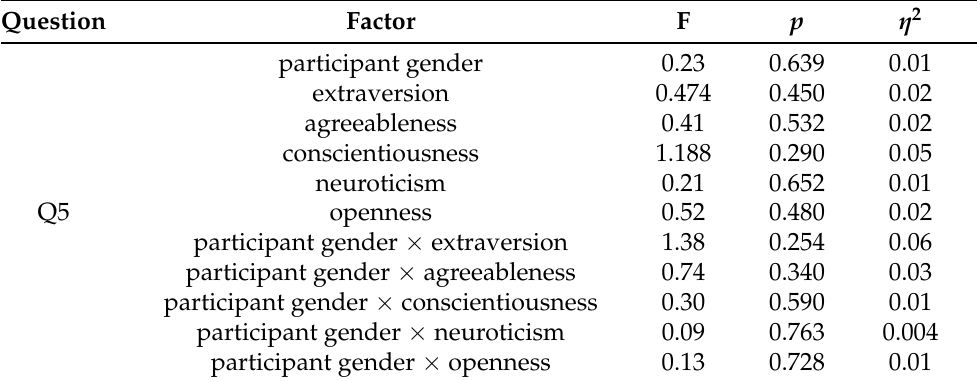
Table A5. GLM analysis of the effect of participants’ personality traits (i.e., extraversion, agreeable- ness, conscientiousness, neuroticism, openness) on their responses to question Q5.